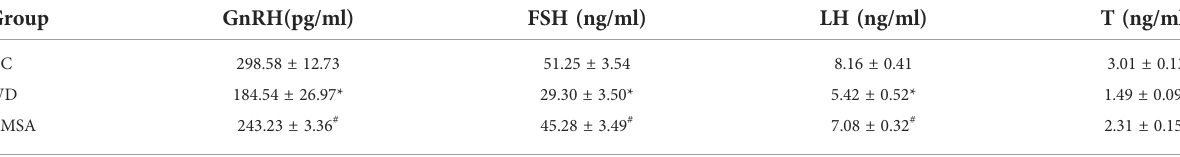
TABLE 2 Comparison of serum GnRH, FSH, LH and T levels in three group ( (cid:1) x s , n=5).